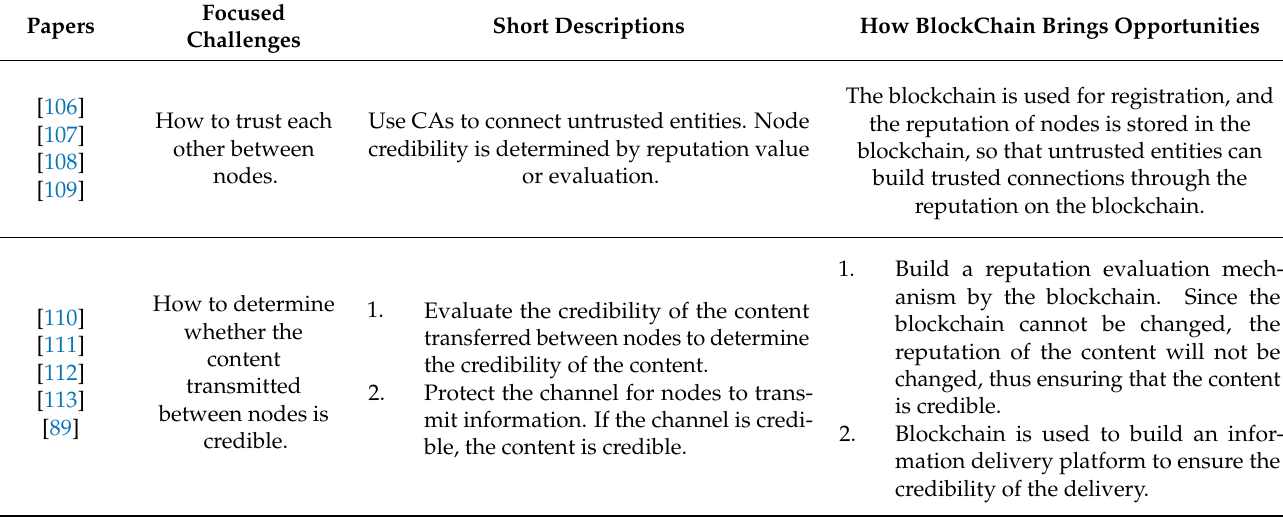
Table 4. Trust Management Related